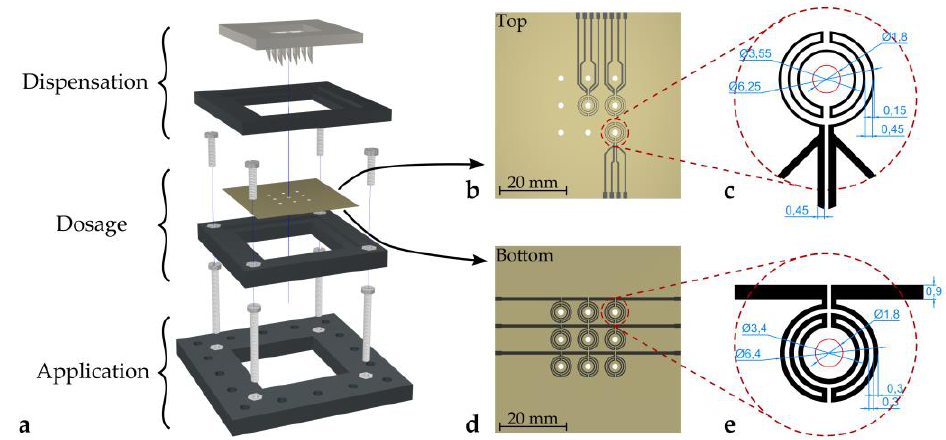
Figure 1. Schematic of the deposition setup. ( a ) Exploded view of the setup with three separate stages (dispensation, dosage, and application). ( b ) Layout of the temperature sensors on the top side of the dosage plate. ( c ) RTD design and dimensions (in mm). ( d ) Layout of the microheater array on the bottom side of the dosage plate. ( e ) Microheater design and dimensions (in mm). Parts (a), (d), and (e): © 2019 IEEE. Reprinted, with permission, from Hintermüller et al. [5].